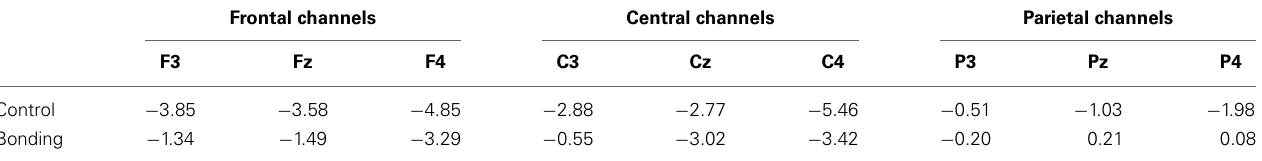
Table 2 | Mean amplitudes of readiness potentials ( μ V) for “Bonding” and “Control”